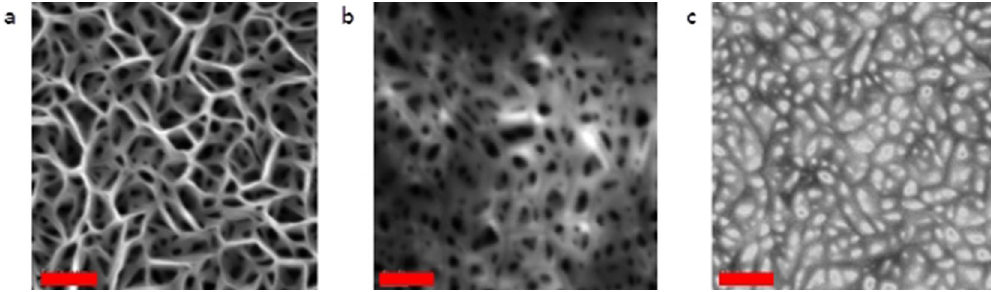
Figure 1. Spatial segregation of emission from nanowalls and nanocavities. ( a ) FESEM plan-view image of w-GaN NwN, ( b ) Panchromatic CL map obtained at room temperature 300 K with applied beam energy of 10 kV and ( c ) 25 kV. Scale bar corresponds to 400